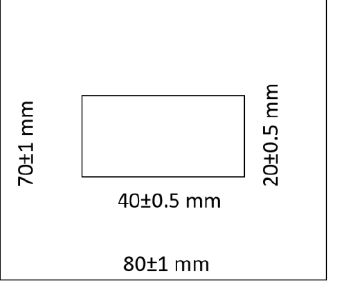
Figure 4. Schematic and pictorials of PTFE frames with and without PLA resin PTFE (Polytetraflu- oroethylene sheets provided by McMaster Carr TM , melting range 327 – 342 °C, relative density 2.14